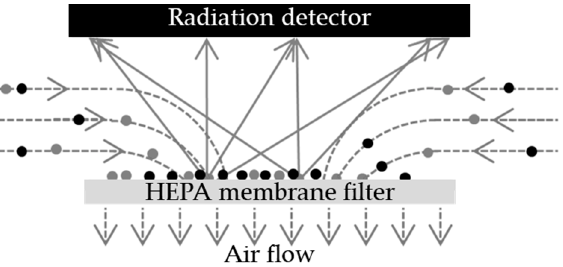
Figure 1. Illustration of the aerosol sampling and measurement of a CAM. The grey circles represent a radioactive aerosol, the black circles a non-radioactive aerosol. Both are sampled and interacts with each other. Dashed arrows represent the air flow and plain arrows the radiations. A dedicated signal treatment converts the nuclear spectrometry to appropriate activity concentra- tions. Radiations are encountered from both natural radioemitters, primarily 220 Rn and 222 Rn daughters, and anthropogenic emitters, such as 239 Pu or 137 Cs. Figure 2 illustrates a CAM radiation measurement. It shows the two relevant regions of interest, dedicated to the artificial alpha (as for the previously cited 239 Pu) and the natural alpha (as for the previously cited 222 Rn daughters, 218 Po and 214 Po). This spectrum is measured with a silicon semiconductor diode which is very well- adapted for alpha measurement.